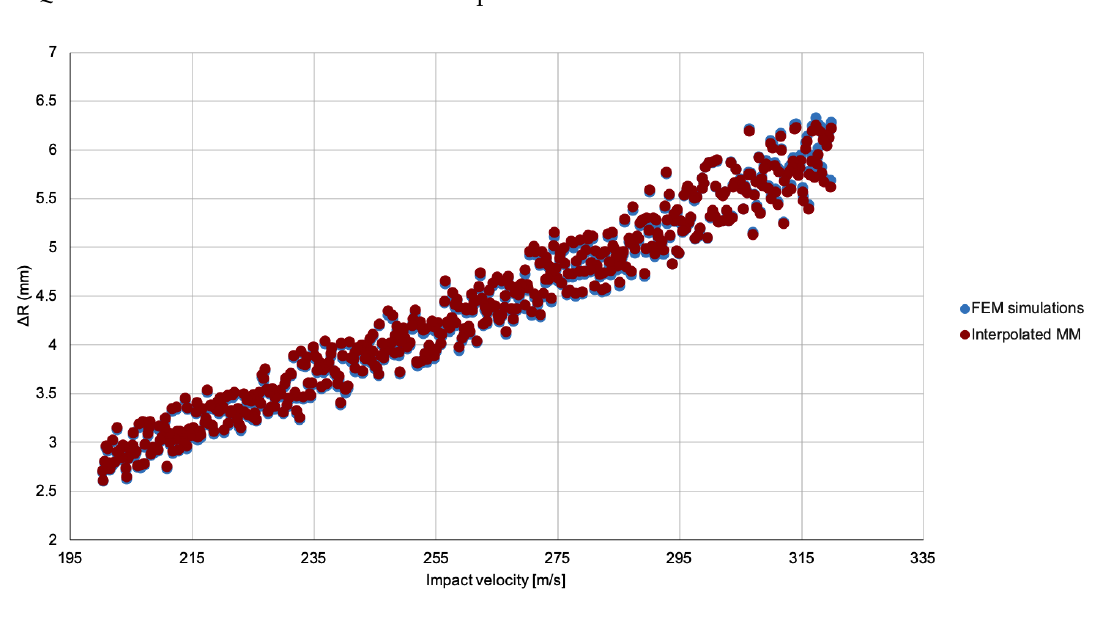
Figure 10. Comparison of meta-models interpolated results and FEM simulations, considering ∆ R for the Johnson–Cook model.